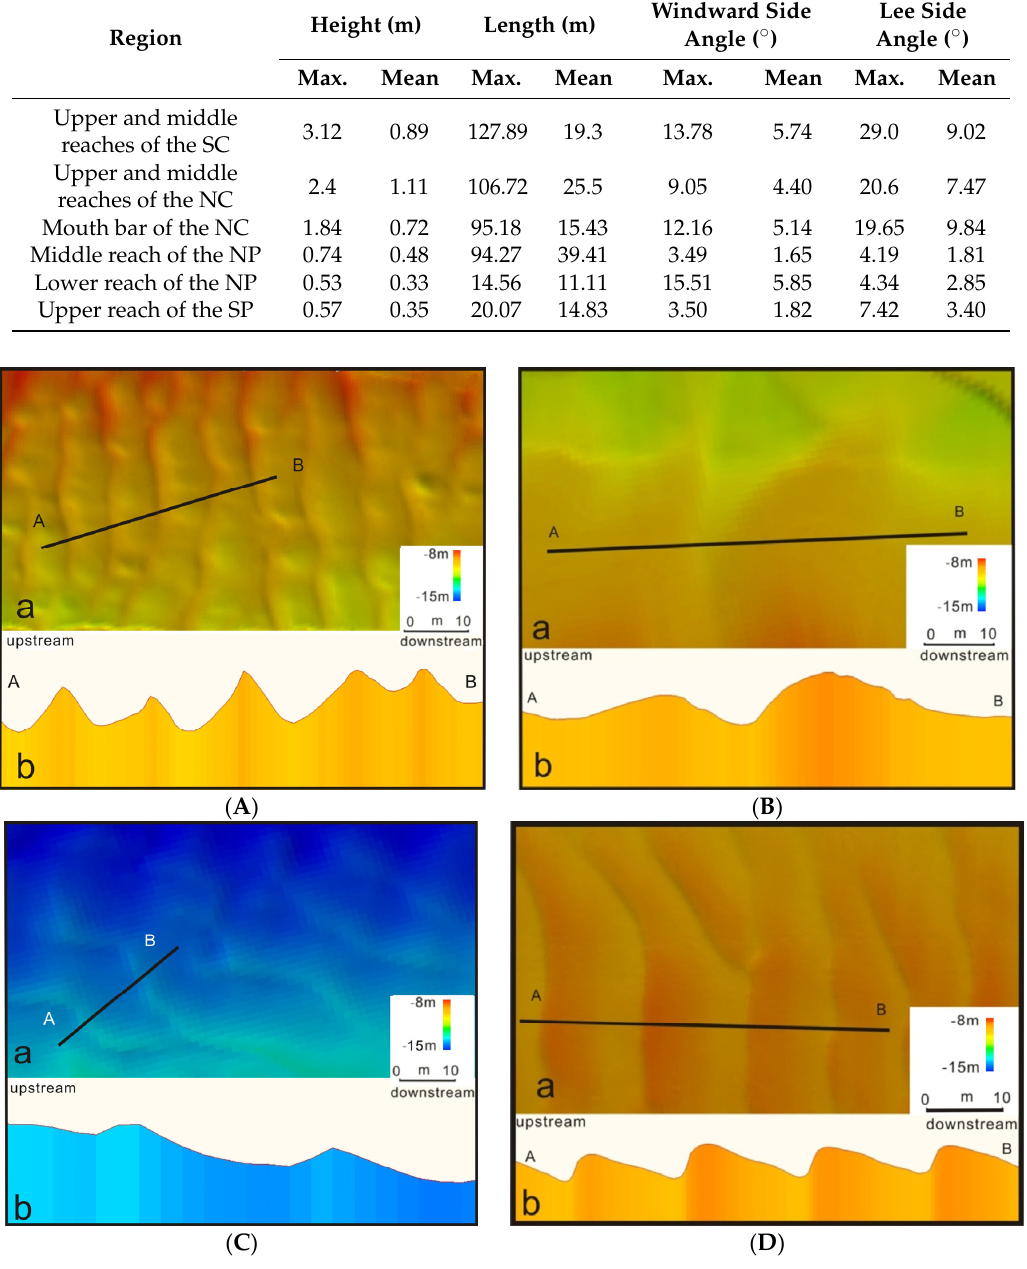
Figure 3. Subaqueous dunes in the turbidity maximum zone of the Yangtze River estuary, including ( A ) the dunes in the mouth bar area of the North Channel; ( B ) the dunes in the middle reach of the North Passage; ( C ) the dunes in the lower reach of the North Passage; and ( D ) the dunes in the south side of Jiangyanansha of the upper reach of the South Passage. Table 1. Characteristics of dunes in the middle and upper reaches, and the turbidity maximum zone of the Yangtze River estuary.